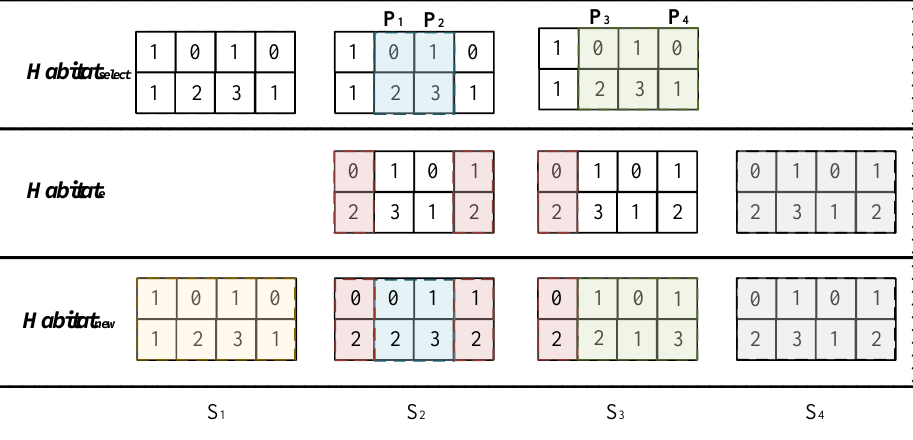
Figure 6. Schematic diagram of the hybrid migration operator.